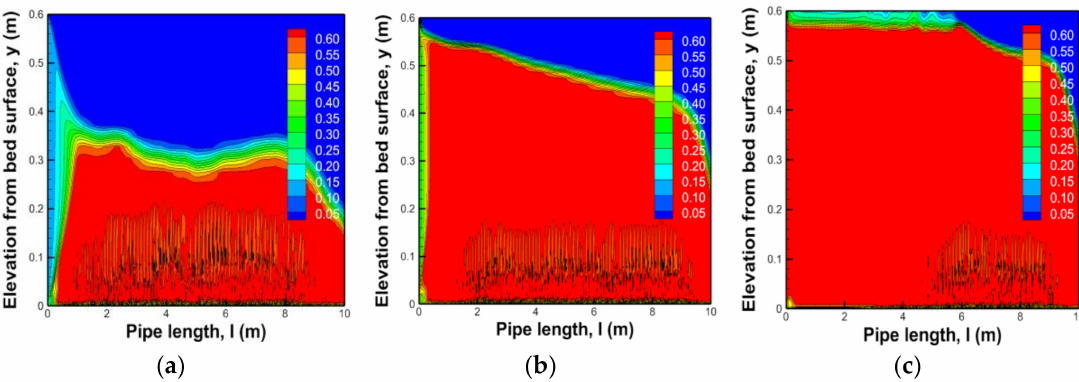
Figure 7. Sedimentation results for soil of diameter 20.0 mm according to changes in volume